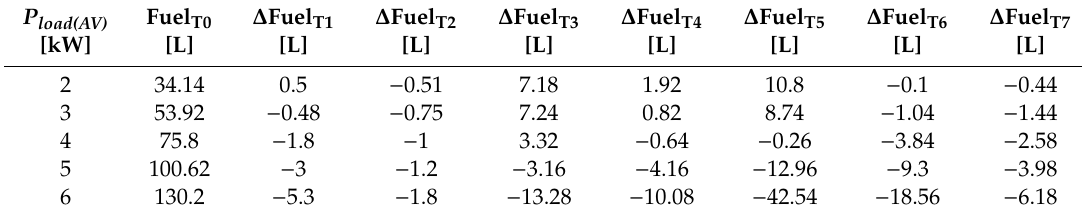
Table 6. Fuel economy for k fuel = 25 and di ff erent P load(AV) .